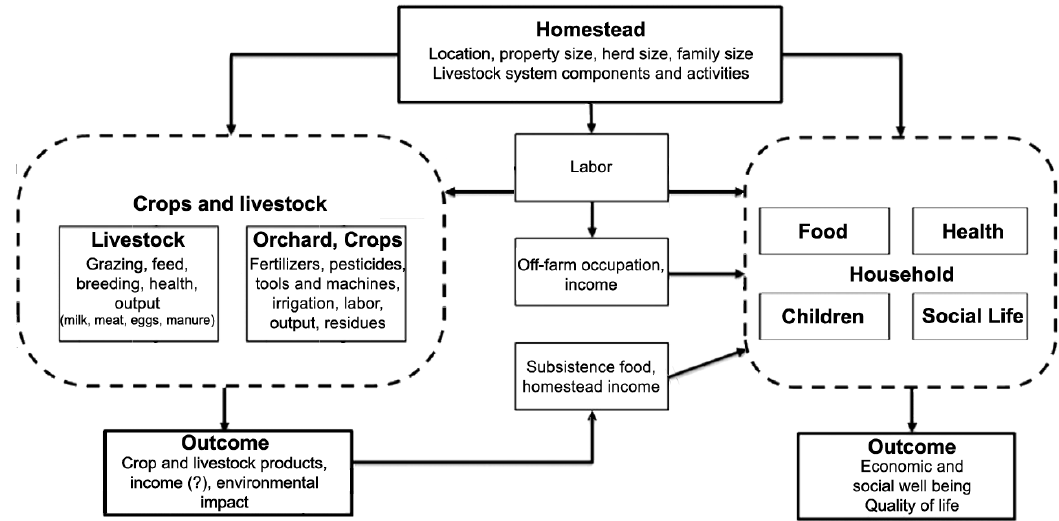
Figure 6. Farming diagram—structure of the system components and interactions, based on [20].